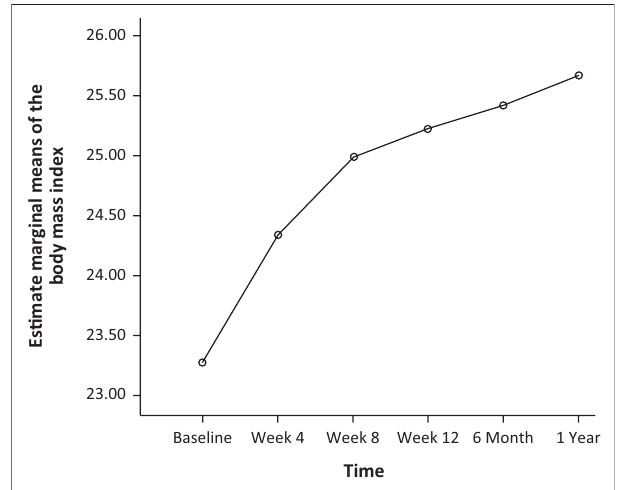
FIGURE 1: Change in the body mass index across the intervals of follow-up.